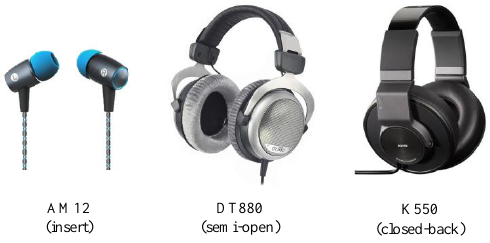
Figure 4. (Color online) The insert, semi-open and closed-back headphones used in the experiments.